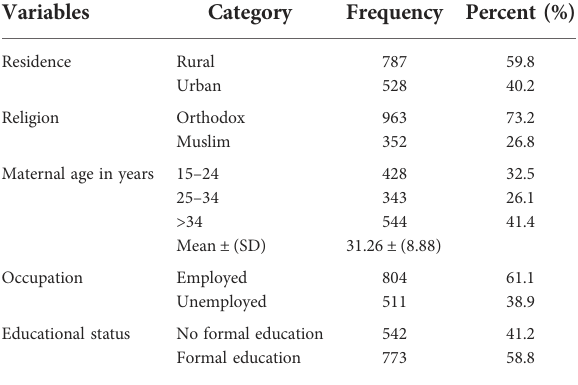
TABLE 1 Socio-demographic characteristics women who gave birth at governmental hospitals of Southwest Ethiopian people regional state, Ethiopia, 2022.